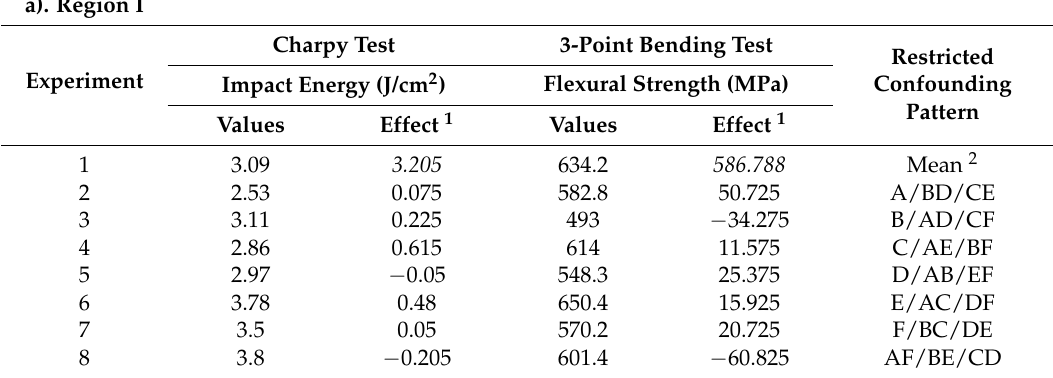
Table 8. Average values and standardized effects for the impact energy absorbed by means of the Charpy test, for the flexural strength and modulus of elasticity obtained by the three-point bending test. a). Region